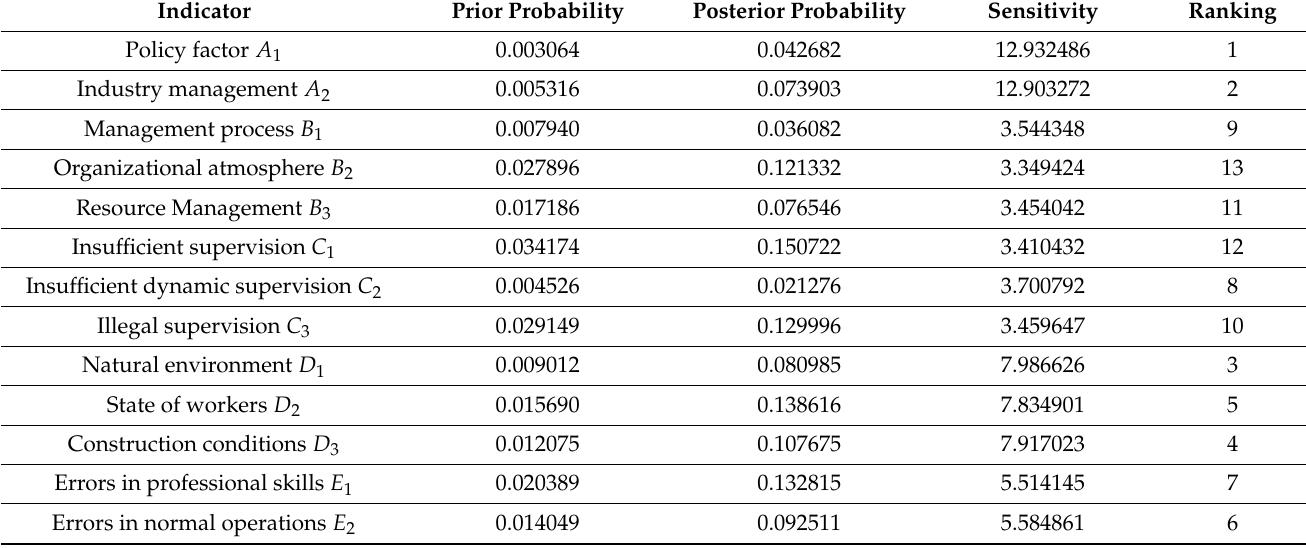
Table 11. Risk factor sensitivity and ranking of each node (second-level